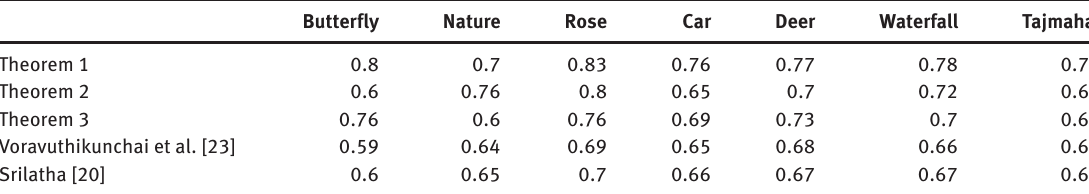
Table 4: Confusion Matrix for k-Means Clustering. Butterfly Nature Rose Car Deer Waterfall Tajmahal Butterfly 37 (37%) 4 (4%) 10 (10%) 9 (9%) 7 (7%) 20 (20%) 14 (14%) Nature 10 (10%) Rose Car 20 (20%) Deer